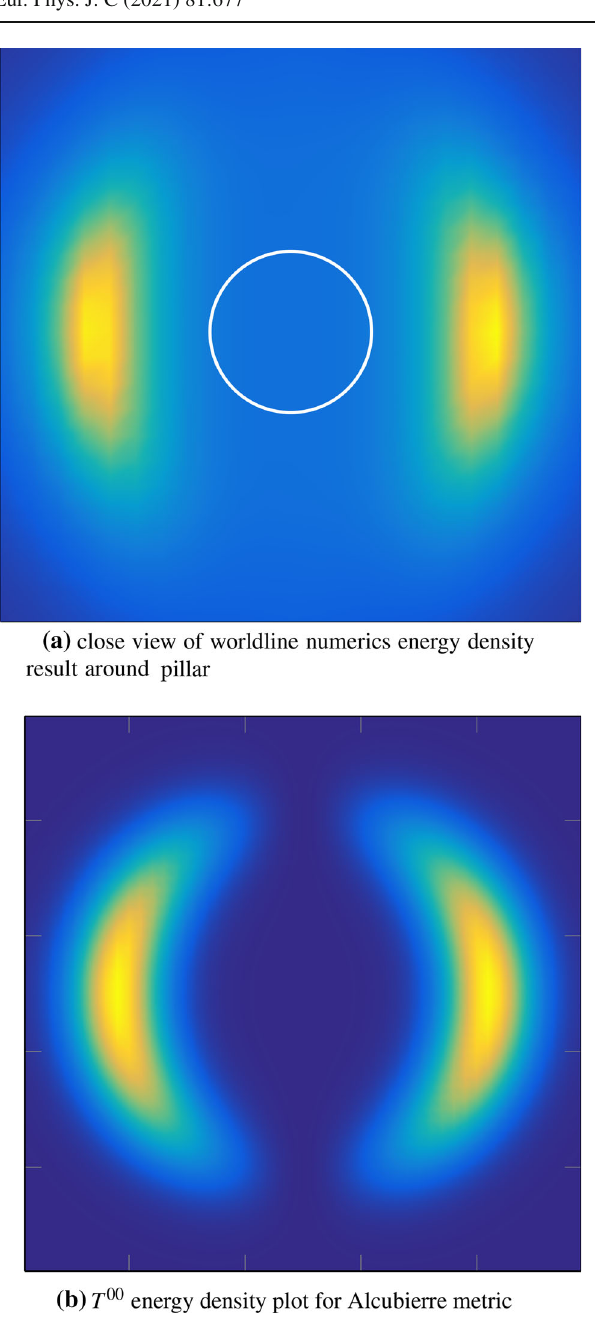
Fig. 9 Comparisonofenergydensityforthenumericworldlineassess- ment of the custom Casimir cavity and and the Alcubierre model energy density requirement